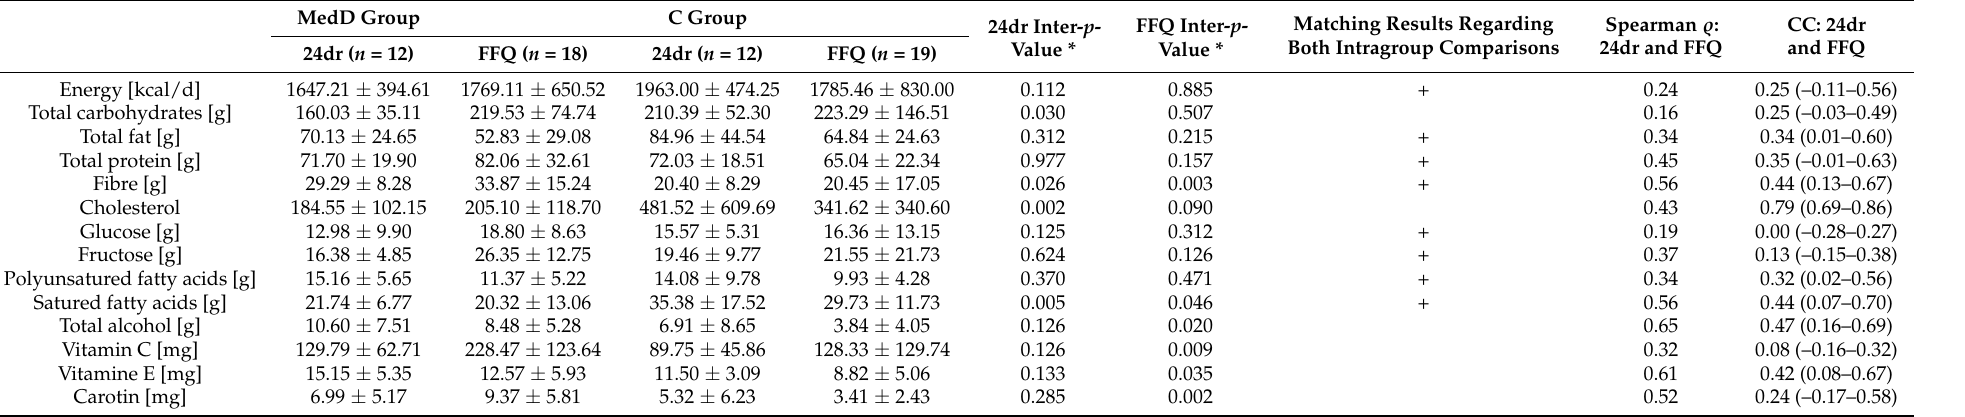
Table 3. Intergroup comparisons at T 2 from both assessment methods. Mean values and standard deviations are given; p -values from the Mann–Whitney U test. Matching results of intragroup comparisons are marked (+). The Spearman rank correlation and concordance correlation coefficient (CC) is shown for the 24dr and FFQ values of both